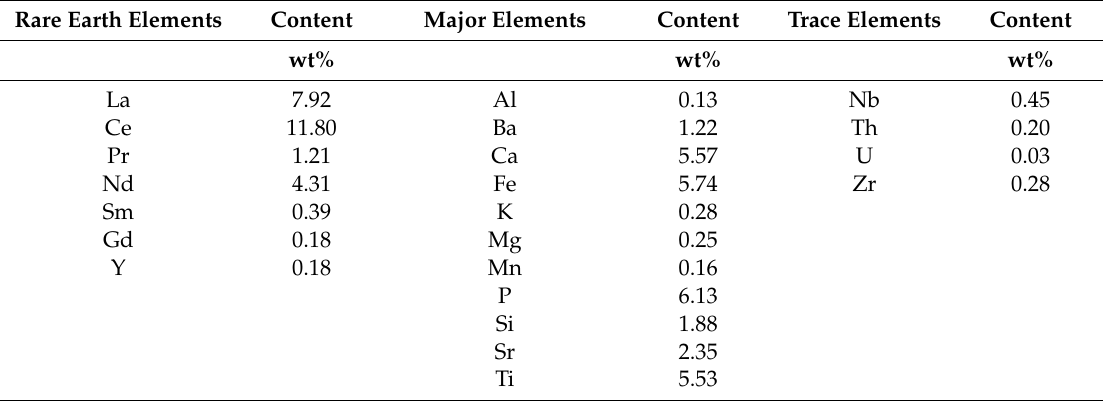
Table 1. Chemical composition of the monazite concentrate. All elements with a weight percentage ≥ 0.1 wt%, and uranium, are